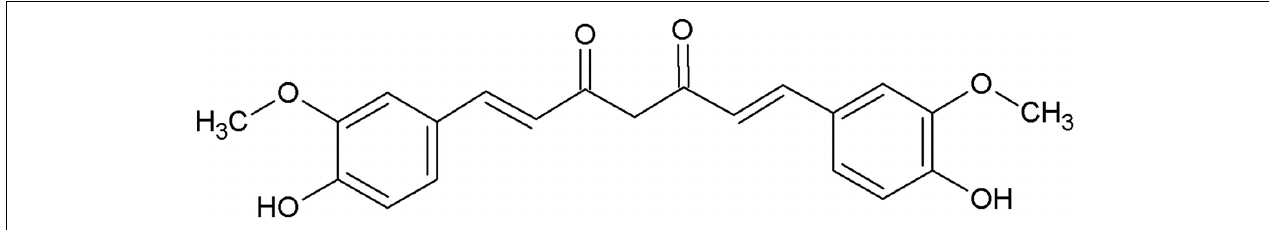
FIGURE 1 | Chemical structure of curcumin.